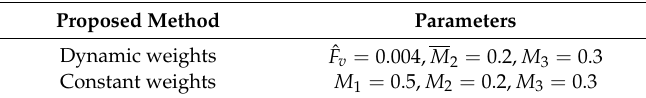
Table 3. Parameters in value function.